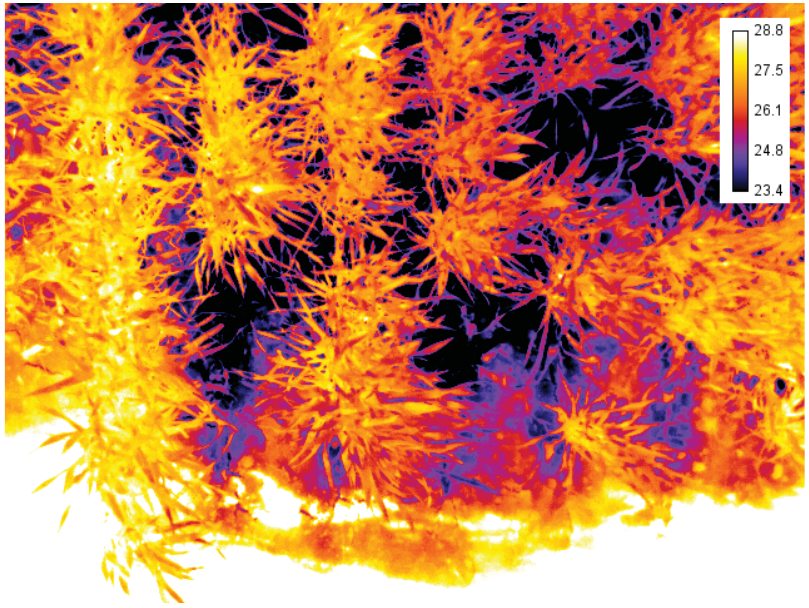
Figure 10. A single thermal image obtained with Phenomobile over wheat. The